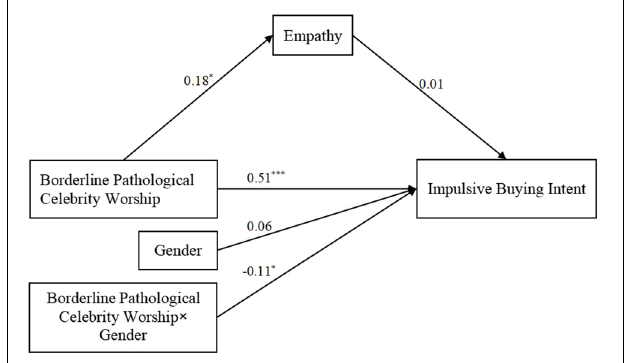
FIGURE 1 | Theoretical moderated mediation